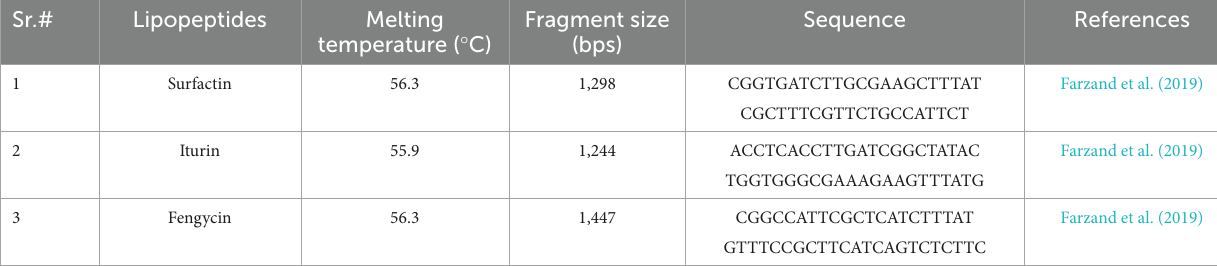
TABLE 1 Primers used in this study to amplify the lipopeptide biosynthetic genes through PCR.